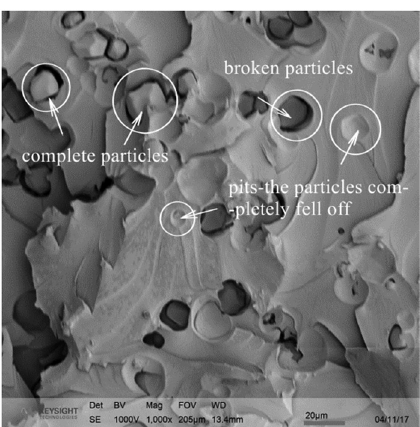
Figure 5: Scanned electron micrographs showing the presence of starch particles.